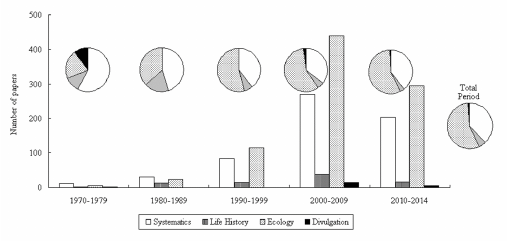
Figure 1. Numbers and relative abundance of papers published per decade (excepting the 2010-2014 period), concerning the broad categories of studies in freshwater benthic invertebrates in Brazil.